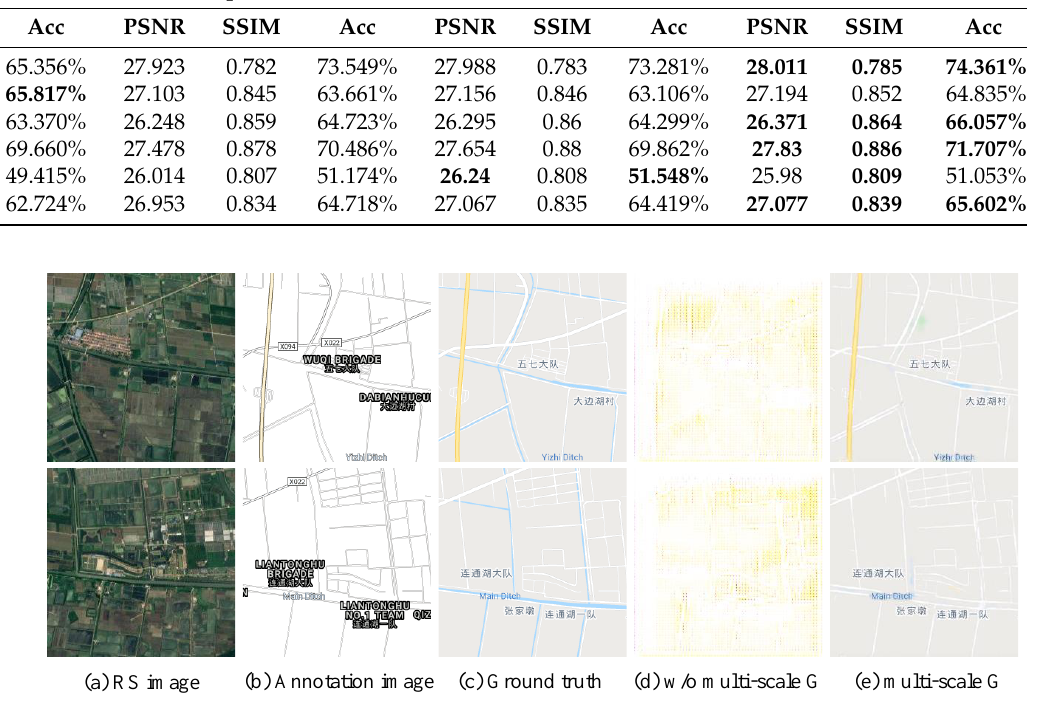
Figure 9. The comparison of generation results with the use of the multi-scale generator and without the use of the multi-scale